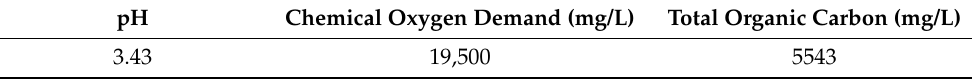
Table 2. Effluent